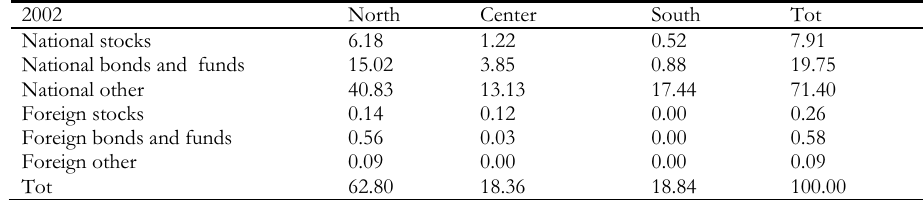
Italian households financial wealth by geographical area of residence, 2002 , percentages